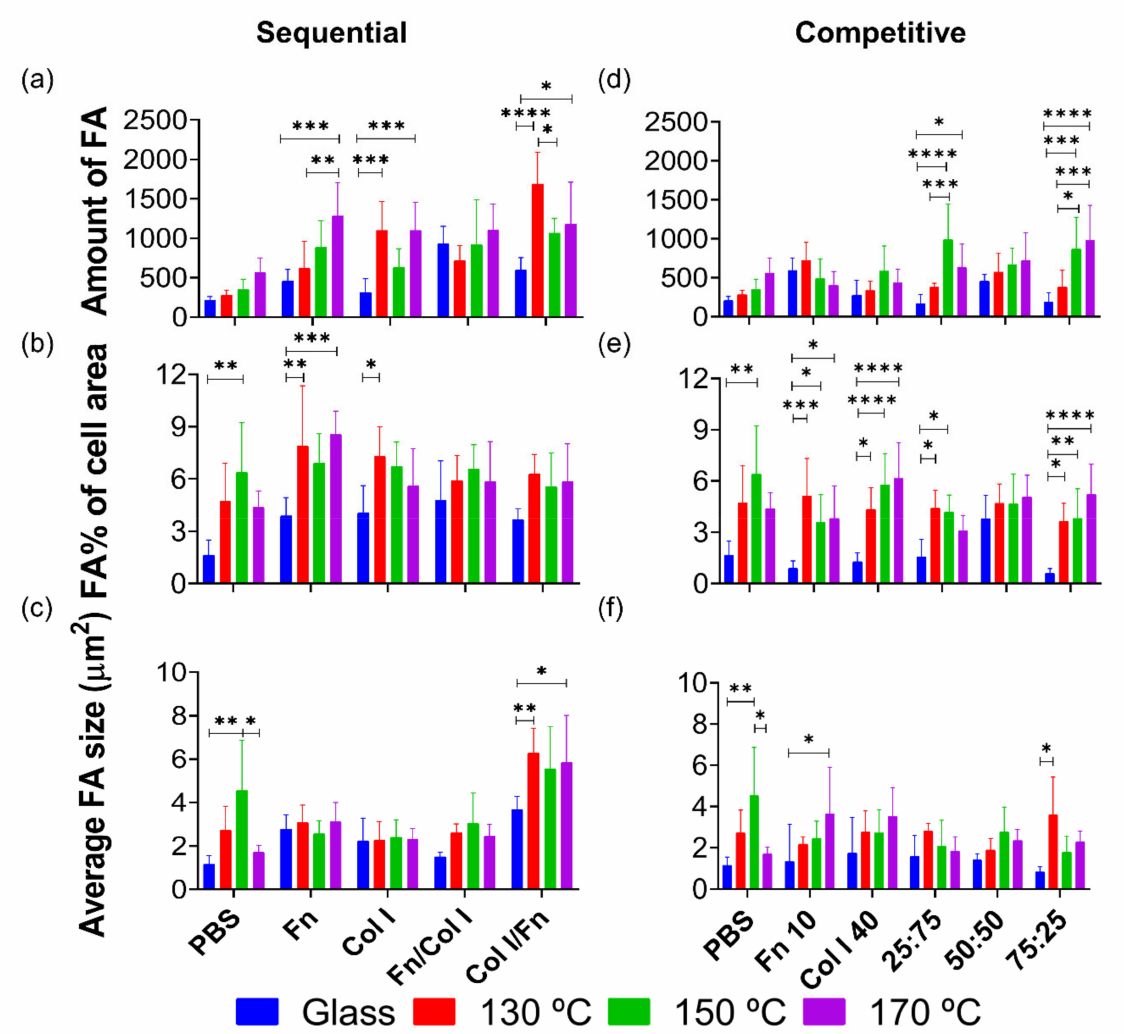
Figure 6. FA parameters of HUVECs cultured on PGS substrates pre-treated in ( a – c ) sequential and ( d - f ) competitive protein adsorption experiments. HUVECs fluorescence quantification of ( a , d ) number of FA, ( b , e ) relative surface of FA compared to the total cell area and ( c , f ) average size of FA, from protein sequential and competitive adsorption assays on glass and PGS cured at different temperatures. FA area was calculated as a percentage (%) of the total cell area. Sample data distributions were analysed through a two-way ANOVA and Bonferroni post hoc multiple mean comparison test, with a p -value < 0.05. *, p < 0.05; **, p < 0.01; ***, p < 0.001; and ****, p <